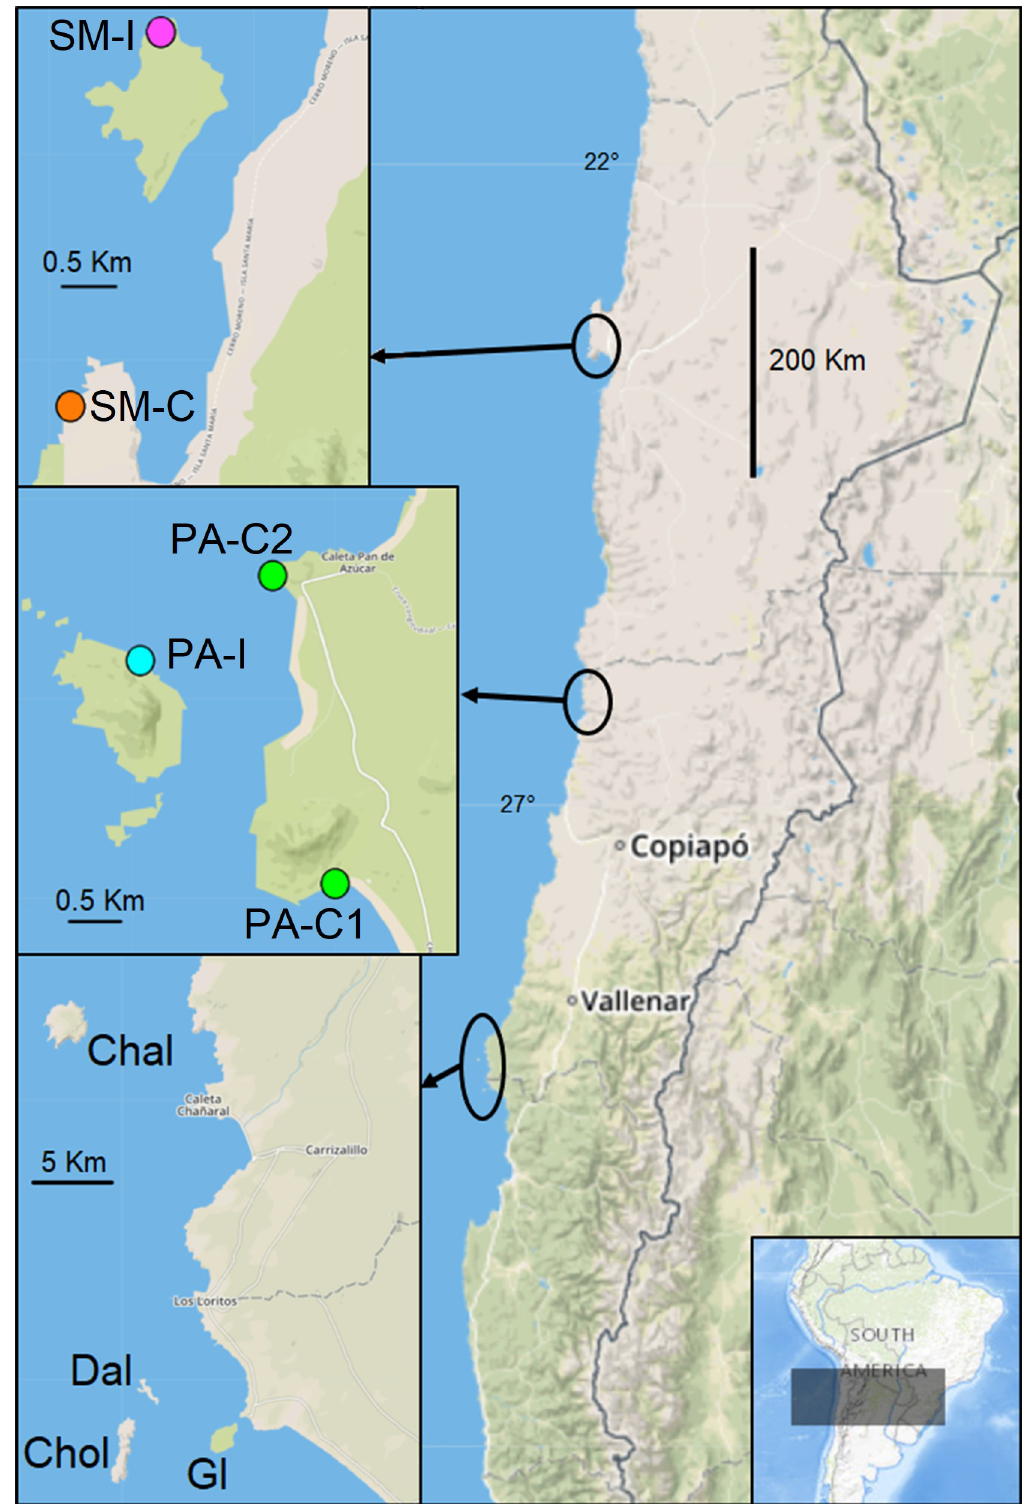
Fig 1. Map of the studied islands. Sampling localities of triatomines. SM-I: Santa Marı´a Island, SM-C: Santa Marı´a continent, PA-I: Pan de Azu´car Island, PA-C: Pan de Azu´car continent. Map was extracted from WHISPers [21] and modified by illustrations